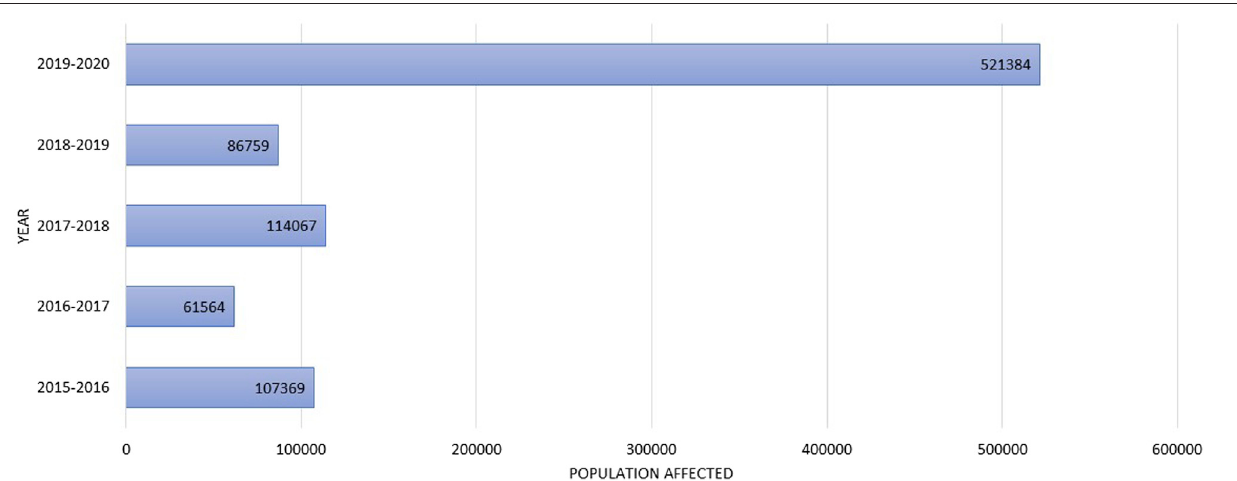
FIGURE 3 | The affected population by seasonal fl u, coughing, and fever reported from 2015 to 2020 November-March data according to the Ministry of Health and family welfare, Bangladesh.